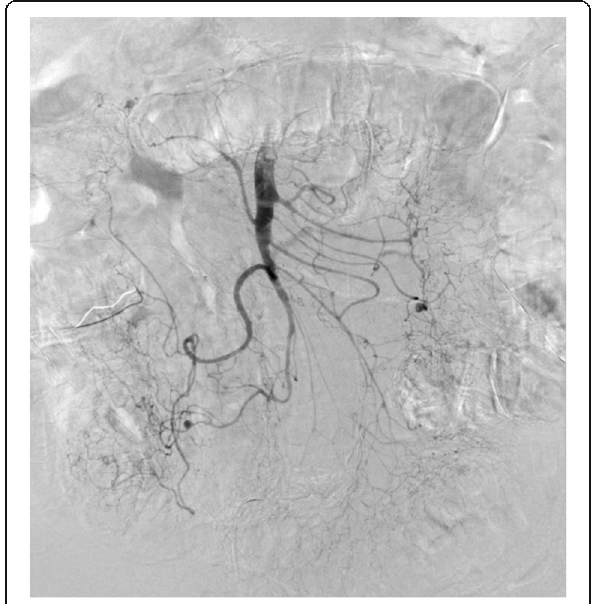
Fig. 5 Seven days posttreatment with transcatheter papaverine infusion from the SMA and prostaglandin from peripheral vein. Mesenteric blood flow was